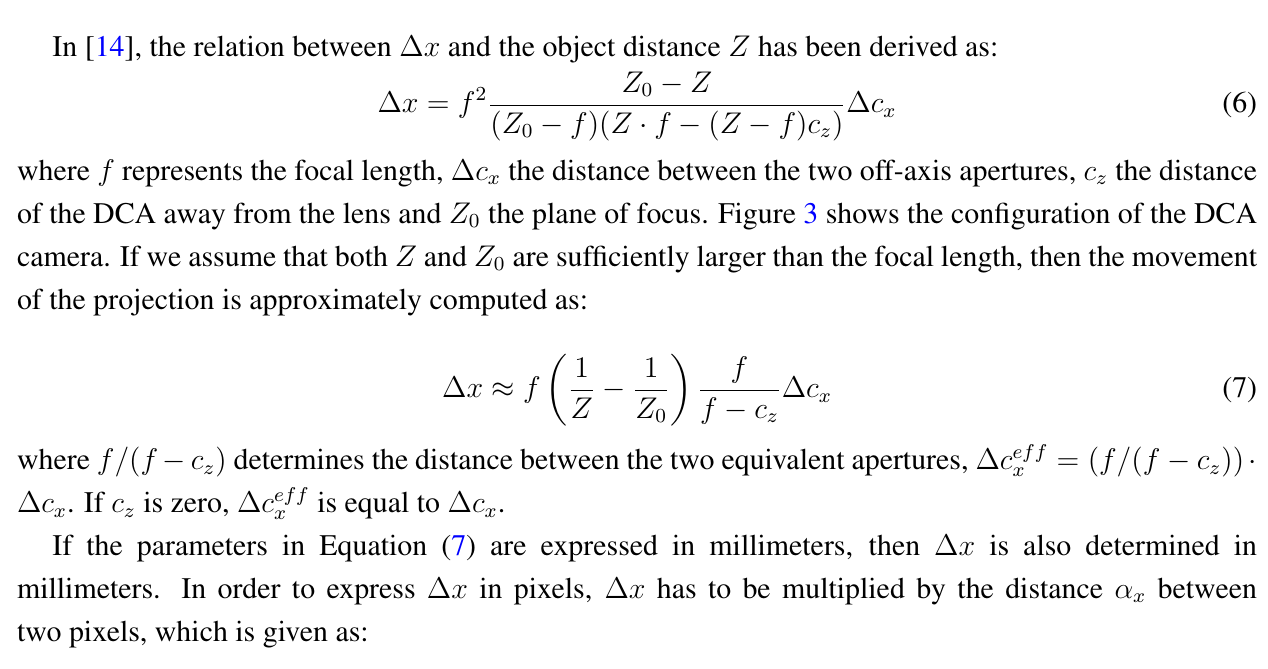
Figure 3. The configuration of the DCA